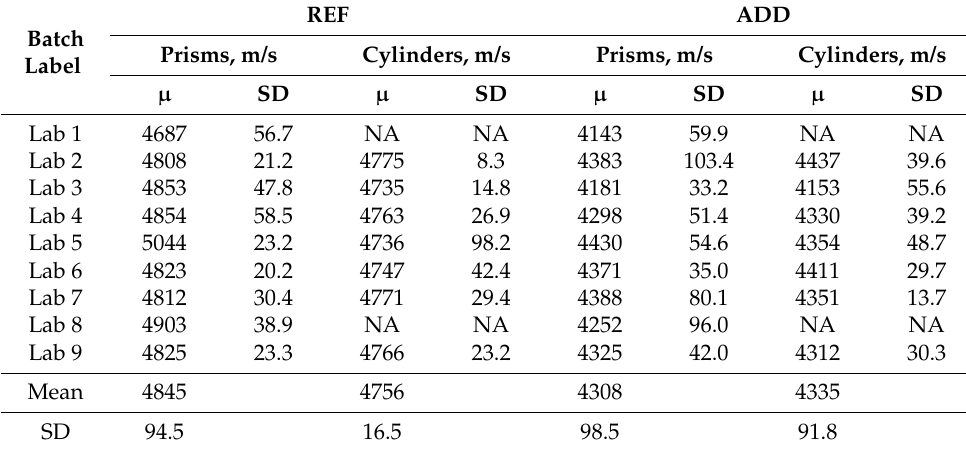
Table 6. Ultrasonic pulse velocity (water saturated) of concrete batches ( µ = mean, SD = standard deviation, and NA = not